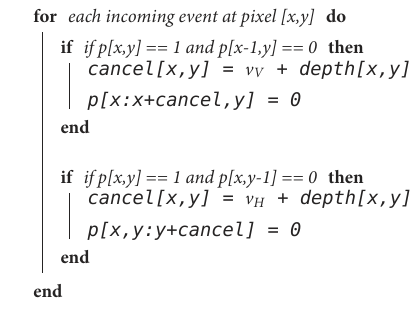
Algorithm 1. Frame-based self-motion